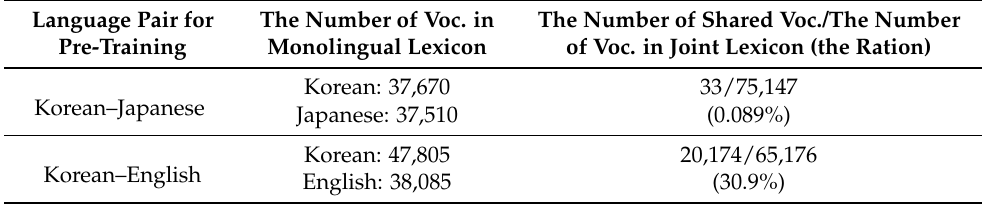
Table 1. The numbers of vocabularies in the lexicons built from each corpus. Language Pair for The Number of Voc. in The Number of Shared Voc./The Pre-Training